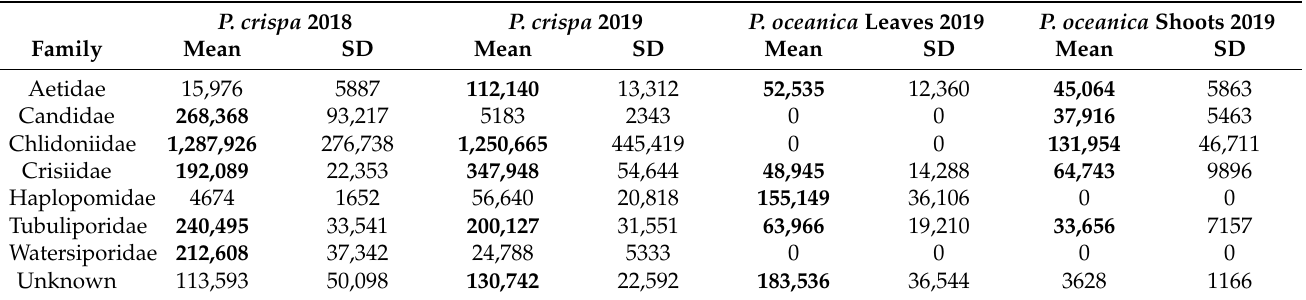
Table 1. Most abundant families of every (sub-) habitat and both years of Phyllophora crispa sampling (top 5 indicated in bold for each habitat) and Posidonia oceanica sampling in 2019. Numbers show the mean number of colonies per m 2 seafloor ± standard deviation